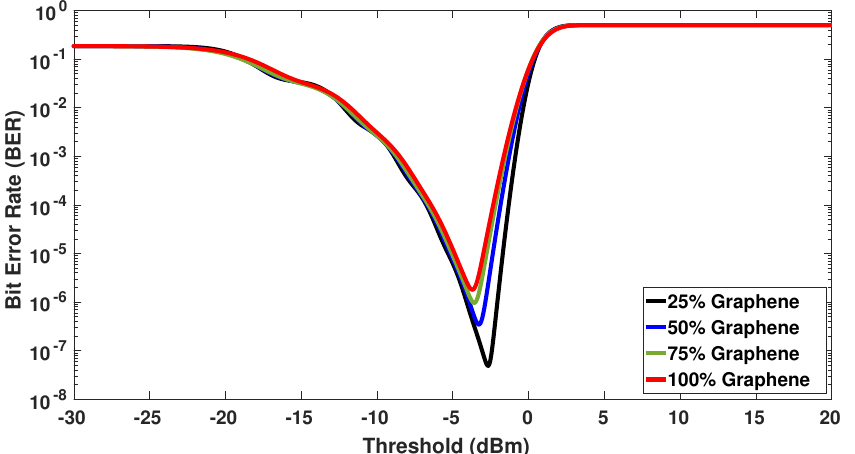
Figure 6. Optimum detection receiver threshold. The BER is minimized by choosing a threshold value of − 2.5 dBm for the 25% graphene